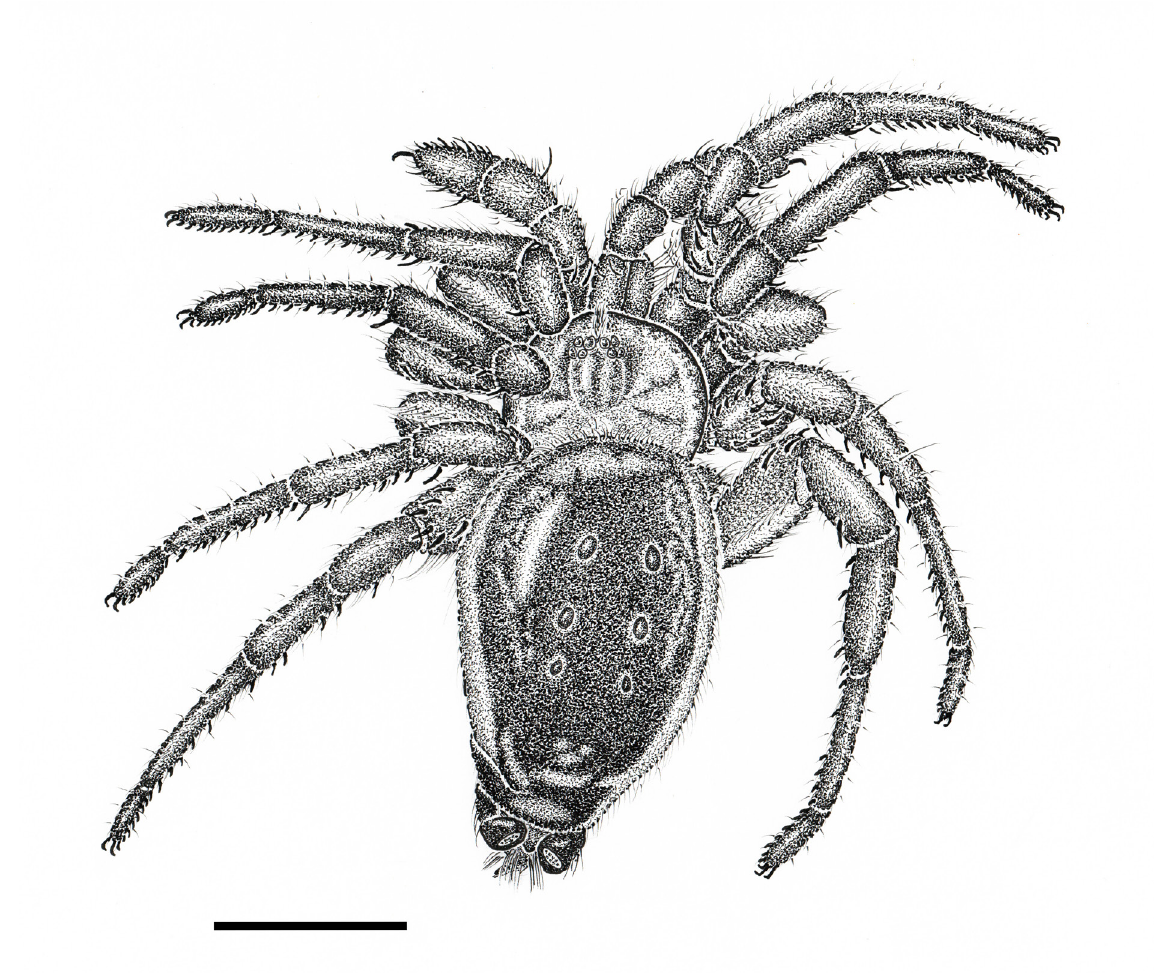
Fig. 5. Uroctea grossa Roewer, 1960, holotype, ♀ (GNM-A497); dorsal habitus. Scale bar = 4